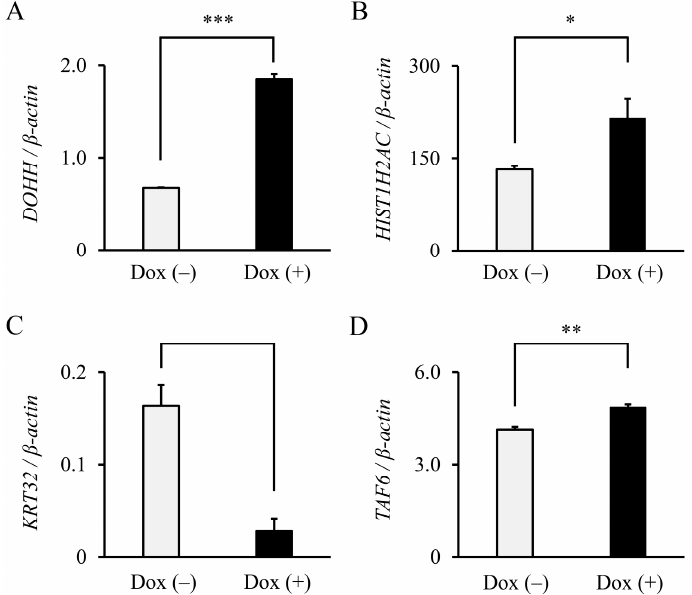
Figure 3. DOHH , HIST1H2AC , and TAF6 mRNA were induced by NRAS signaling. ( A ) DOHH , ( B ) HIST1H2AC , ( C ) KRT32 , and ( D ) TAF6 mRNA expression in THP-1 B11 cells cultured in the absence and presence of Dox were analyzed by RT-qPCR. Relative mRNA expression was shown as delta–delta Ct values normalized by β -actin mRNA ( n = 3). Data are expressed as mean ± SD. Statistical significance was determined using an unpaired t -test. * p < 0.05, ** p < 0.01, and *** p < 0.001.